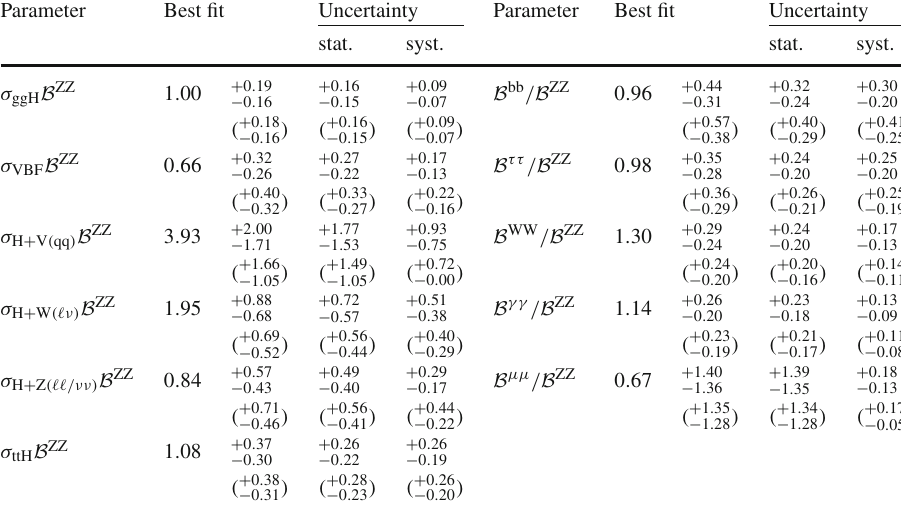
Table 5 Best fit values and ± 1 σ uncertainties for the parameters of the stage 0 simplified template cross section model. The values are all normalized to the SM predictions. The expected uncertainties are given in